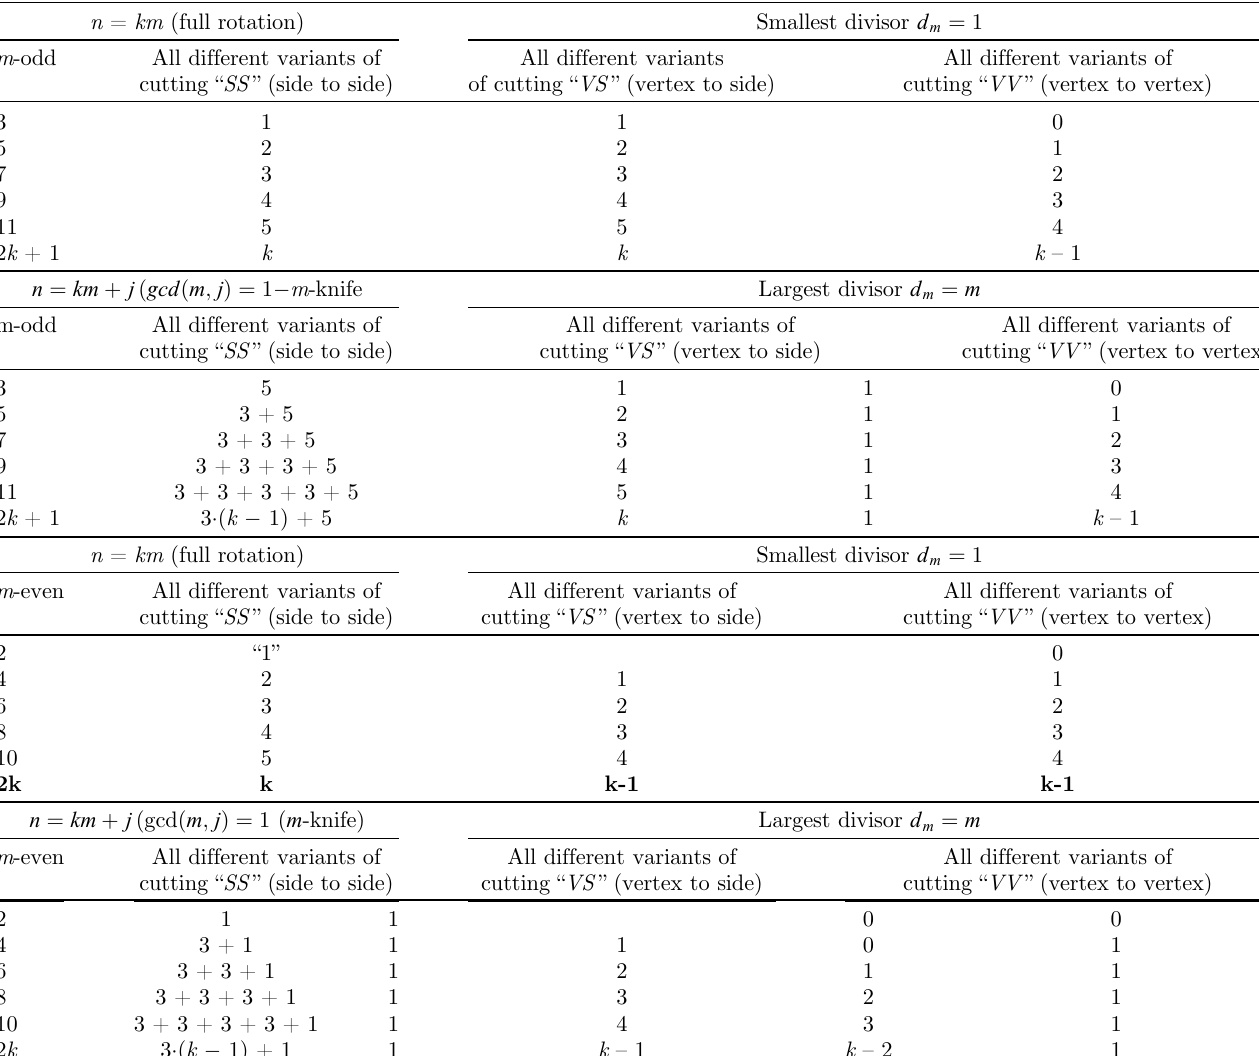
Table 3. GML cutting with moving knives.